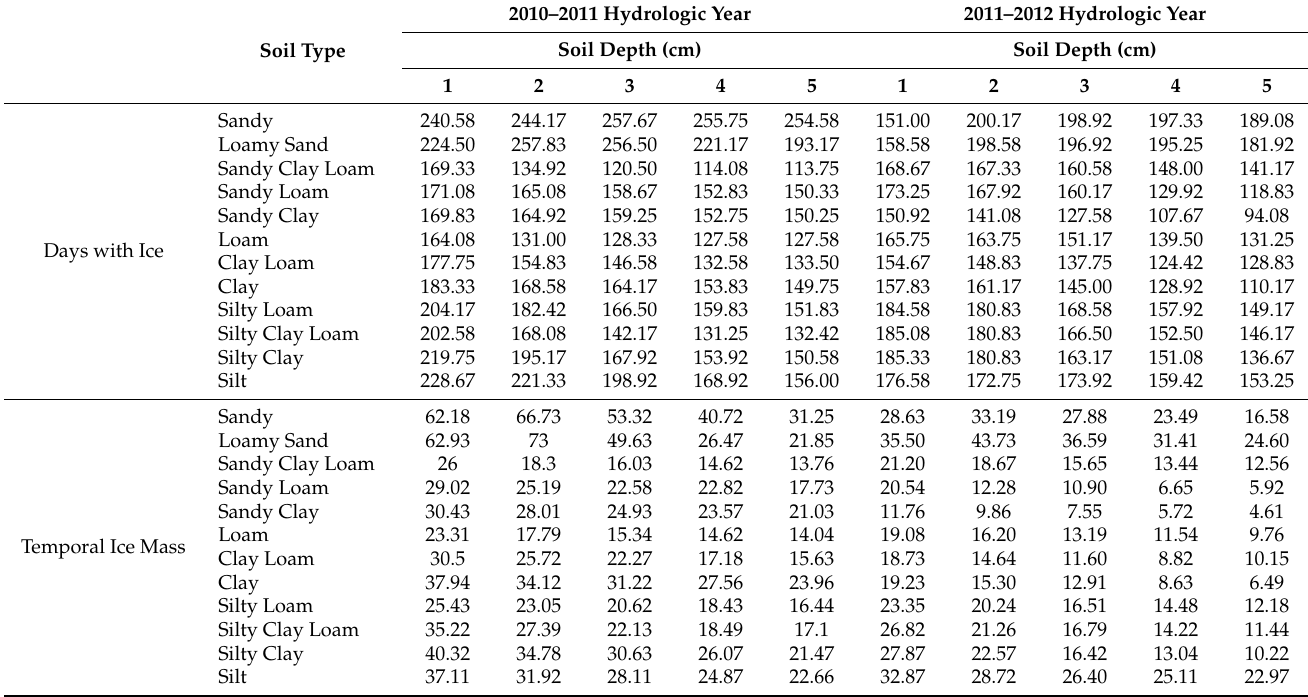
Table 4. Days with ice and temporal ice mass metrics for both hydrologic years analyzed within the first 5 cm depth (first five soil